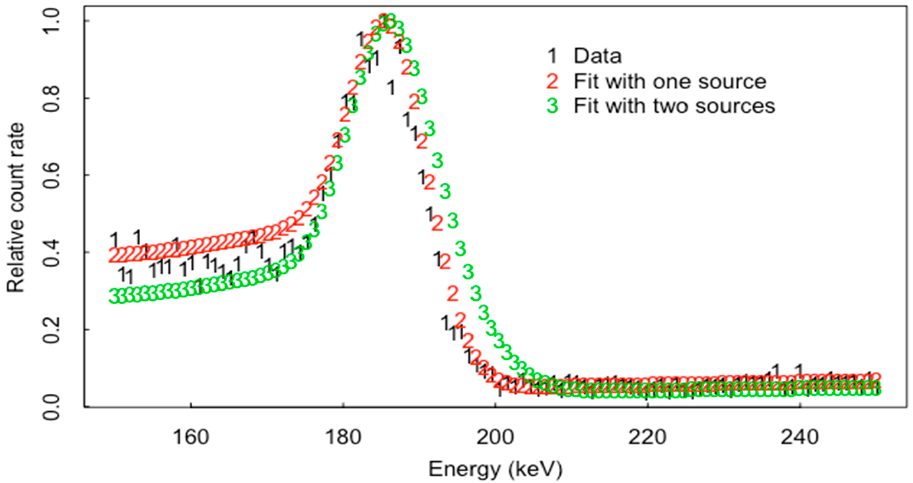
Figure 3. Raw data and example fits to one peak or to two peaks.